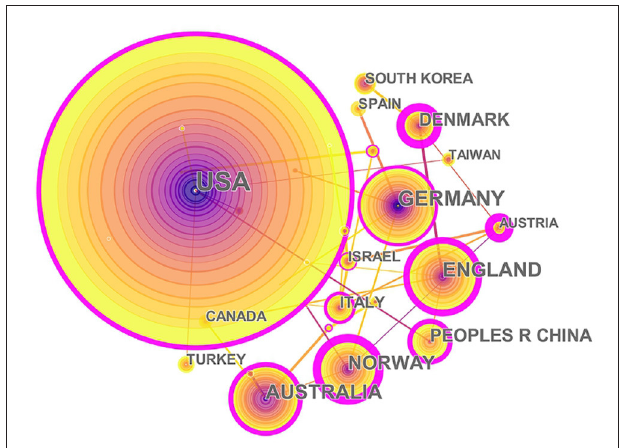
FIGURE 4 | The collaborations of countries or regions interested in the field. In this map, the node represents a country, and the link represents the cooperation relationship between two countries. A larger node represents more publications in the country. A thicker purple circle represents greater influence in this field.